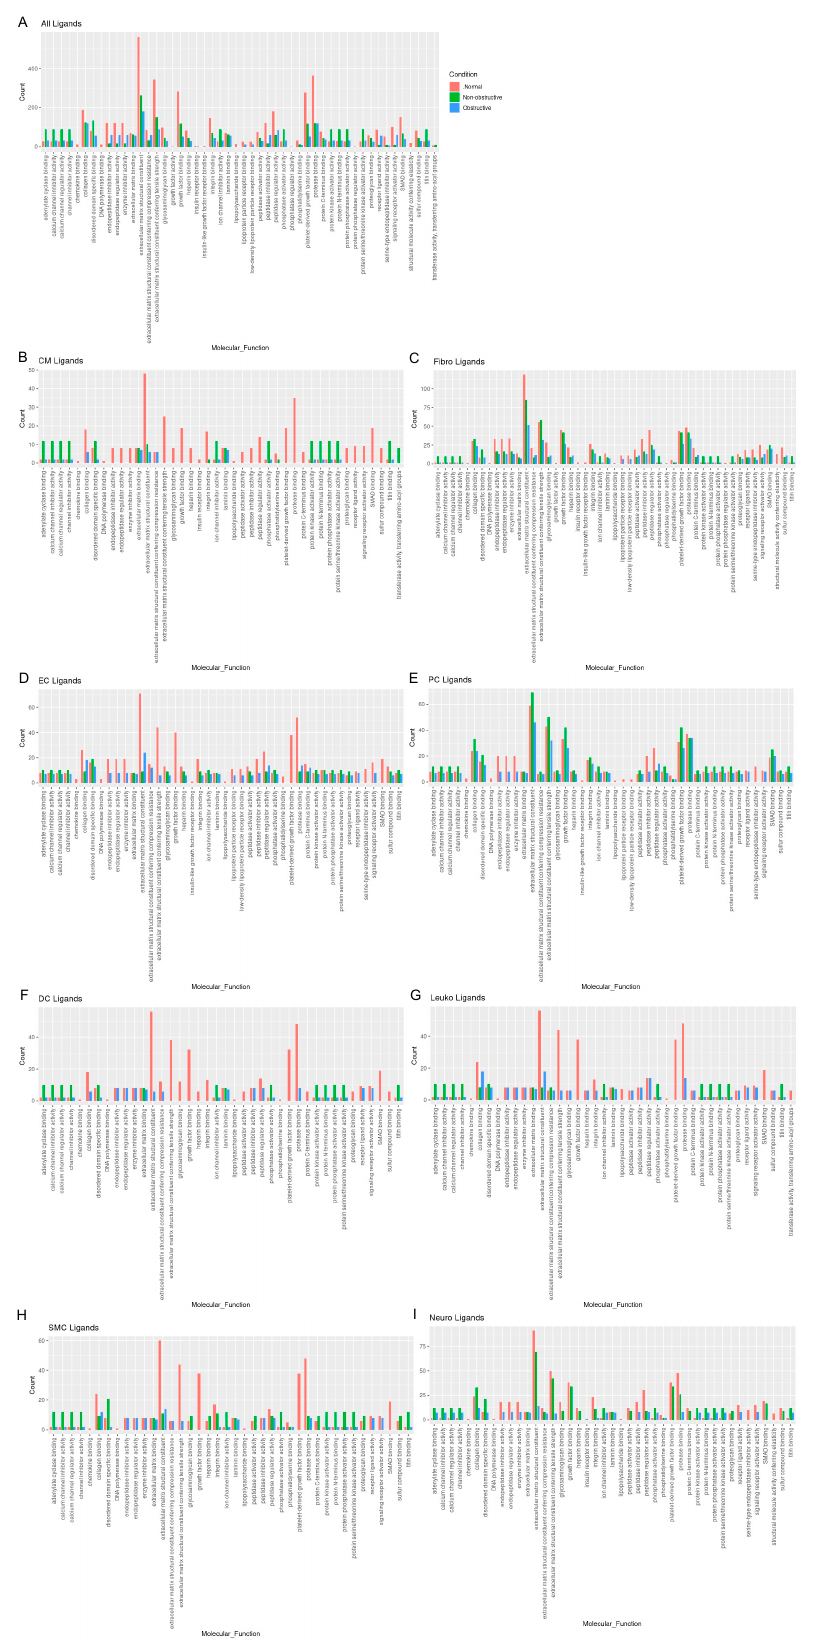
Figure 5. Bar plot representing the total count of ligands (in expressed ligand–receptor pairs) associated with different cellular processes in normal, nonobstructive HCM, and obstructive HCM IVS Cells.